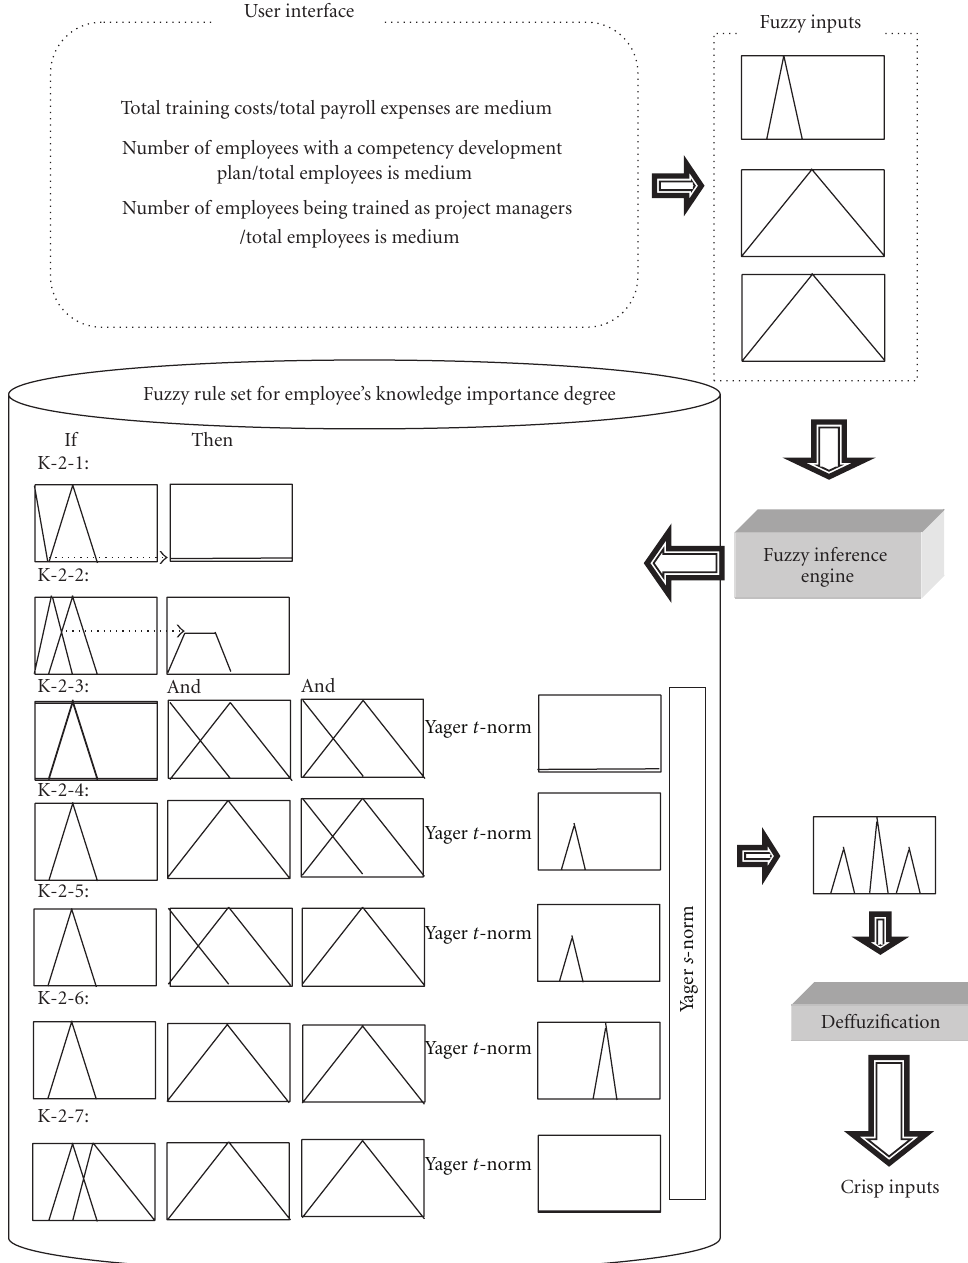
Figure 8: Sample procedure for measuring employee’s knowledge with proposed fuzzy expert